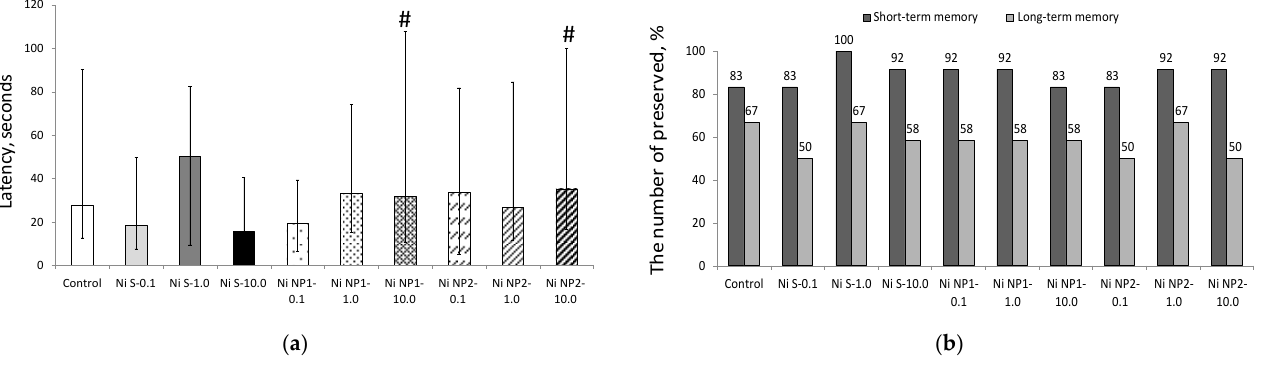
Figure 6. Parameters of rats in the CRPA test: ( a ) latency of entry into the dark chamber, seconds (Med, interval of change); ( b ) the number of animals retaining short-term and long-term memory, %. #—the difference with the group that received the Ni salt in an equivalent dose is significant; p < 0.05. The number of animals is 12 in each group.